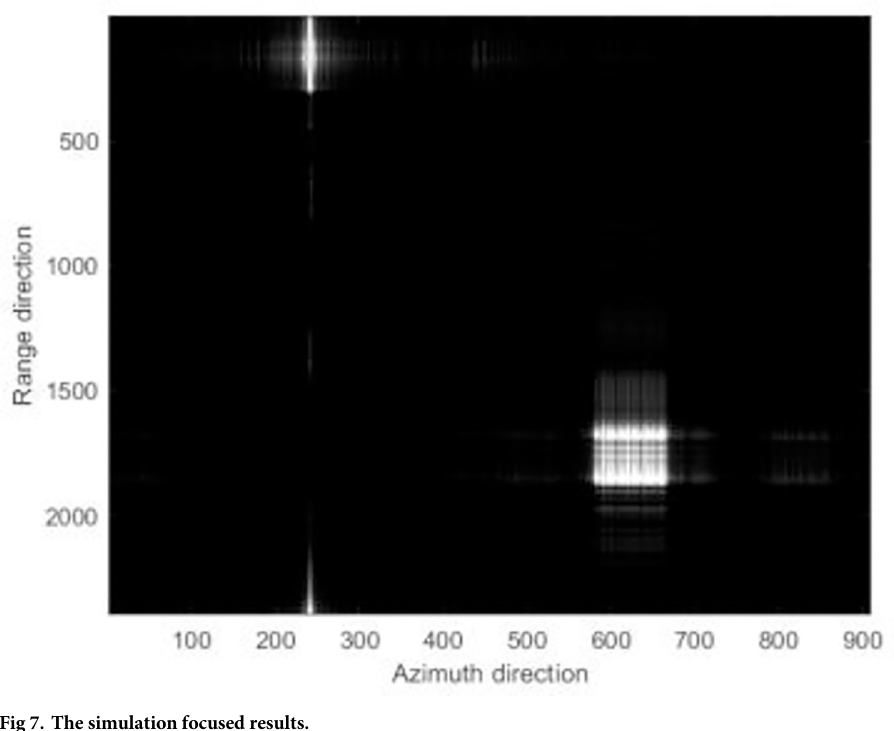
Fig 7. The simulation focused results.